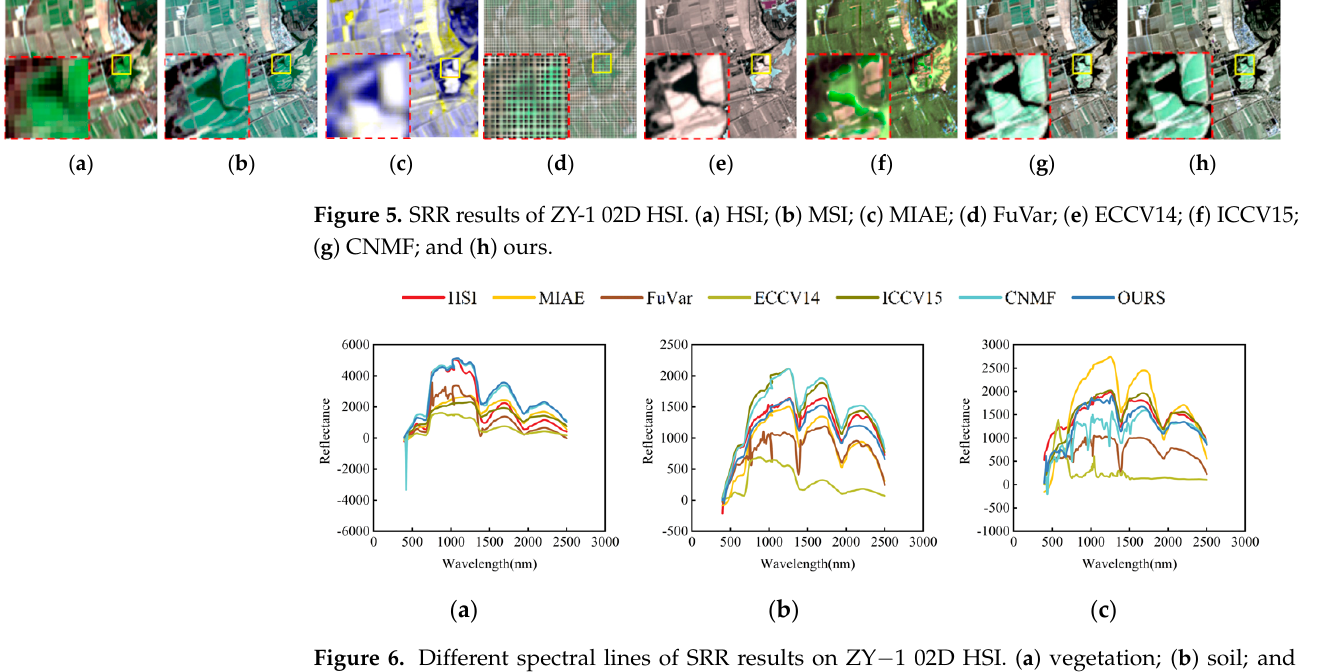
Figure 5. SRR results of ZY-1 02D HSI. ( a ) HSI; ( b ) MSI; ( c ) MIAE; ( d ) FuVar; ( e ) ECCV14; ( f ) ICCV15; ( g ) CNMF; and ( h ) ours.